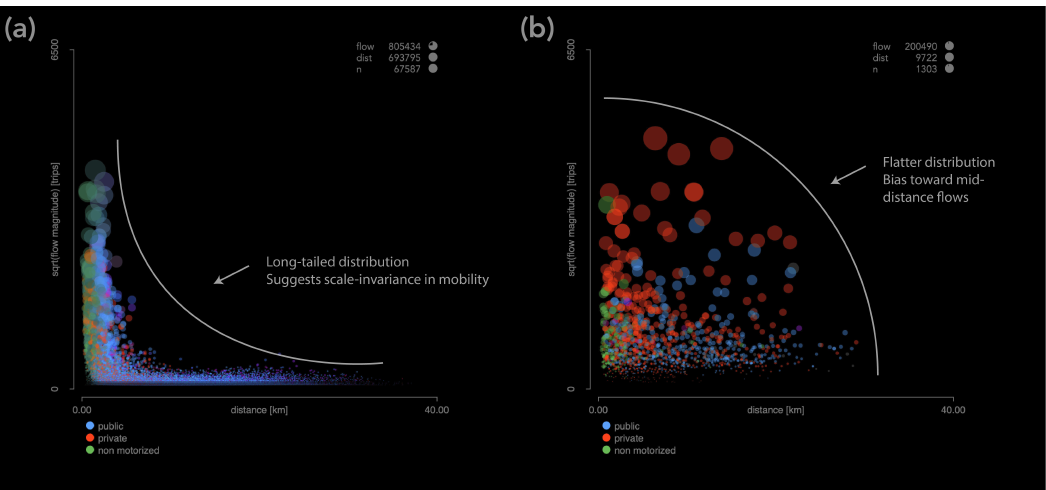
Figure 5. Pervasive ( a ) and survey ( b ) flows at night time. Each circle is an origin-destination pair, its area the flow magnitude, with color coded mode split. Highlighted are the different overall shapes present in their distribution.